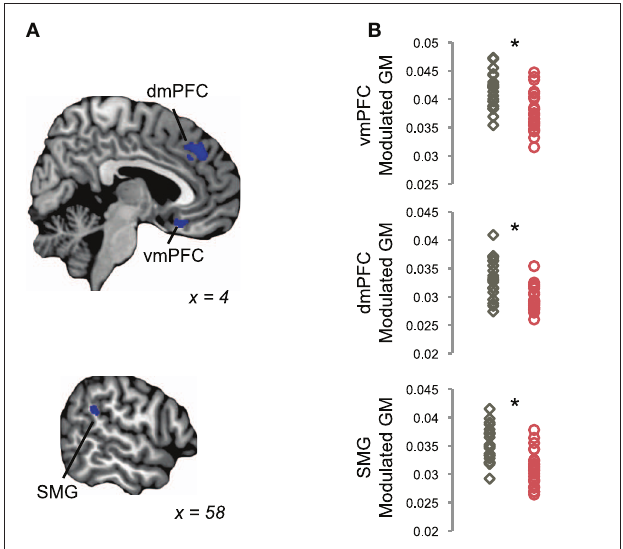
FIGURE 2 | Reductions in gray matter in tinnitus, using a volume-based analysis. (A) Tinnitus patients showed reduced GM volume in ventromedial prefrontal cortex (vmPFC), dorsomedial prefrontal cortex (dmPFC), and supramarginal gyrus (SMG), as compared to control participants in a whole-brain voxel-based morphometry (VBM) analysis (blue). Statistical maps of between-groups differences are shown on parasagittal slices through single-subject template anatomy; the X-dimension in MNI space is displayed for each view. (B) Plots show mean modulated GM values in each cluster shown in (A) for each tinnitus patient (red) and control participant (gray). Asterisks indicate a significant difference between groups, as assessed by the whole-brain analysis in (A)